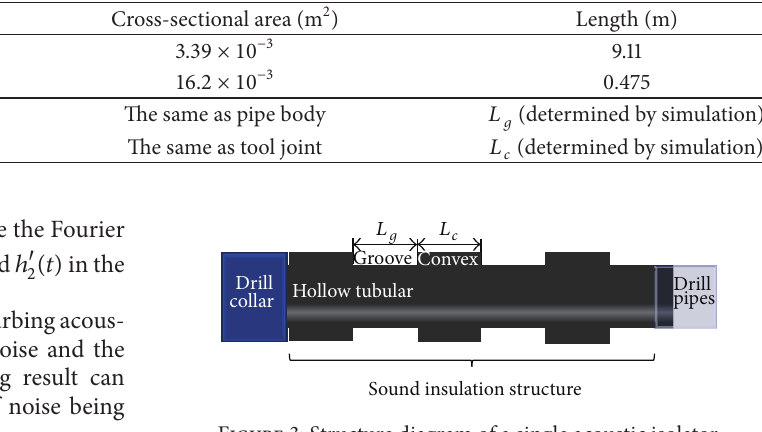
Figure 3: Structure diagram of a single acoustic